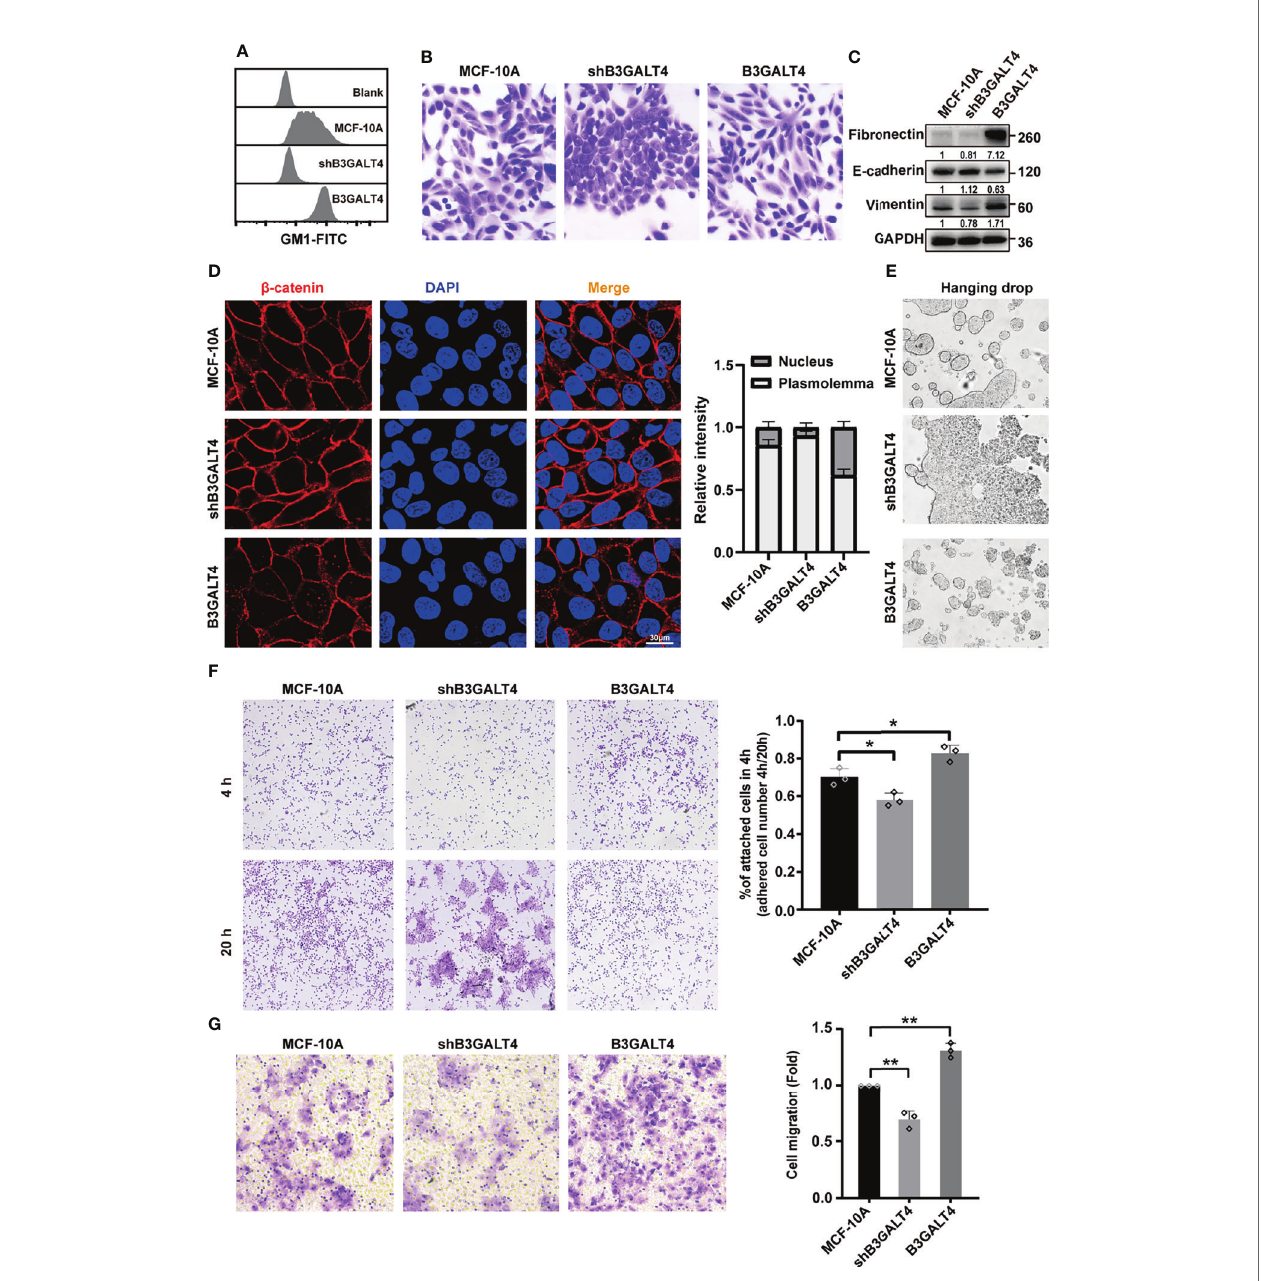
FIGURE 1 | GM1 induces EMT process in MCF-10A cells. (A) Expression of GM1 in parental, B3GALT4-transfected and -silenced MCF-10A cells (termed as B3GALT4 or shB3GALT4), evaluated by fl ow cytometry. Blank indicates unstained MCF-10A cells. MCF-10A, shB3GALT4, and B3GALT4 indicate parental, B3GALT4-silenced, and B3GALT4-overexpressed cells stained with CTB-Biotin. (B) Morphology of parental, B3GALT4-transfected and -silenced MCF-10A cells. (C) Expression of fi bronectin, E-cadherin, and vimentin of cells evaluated by Western blot. (D) Expression and localization of b -catenin evaluated by immuno fl uorescence assay. (E) Cell – cell adhesion of parental, B3GALT4-transfected and -silenced MCF-10A cells evaluated by hanging drop aggregation assays. (F) The cell-matrix adhesion of cells evaluated by cell adhesion assay. (G) The migratory ability of parental, B3GALT4-transfected and -silenced MCF-10A cells evaluated by transwell assay. The above experiments were performed in triplicate wells and independently conducted three times. * p < 0.05, ** p <